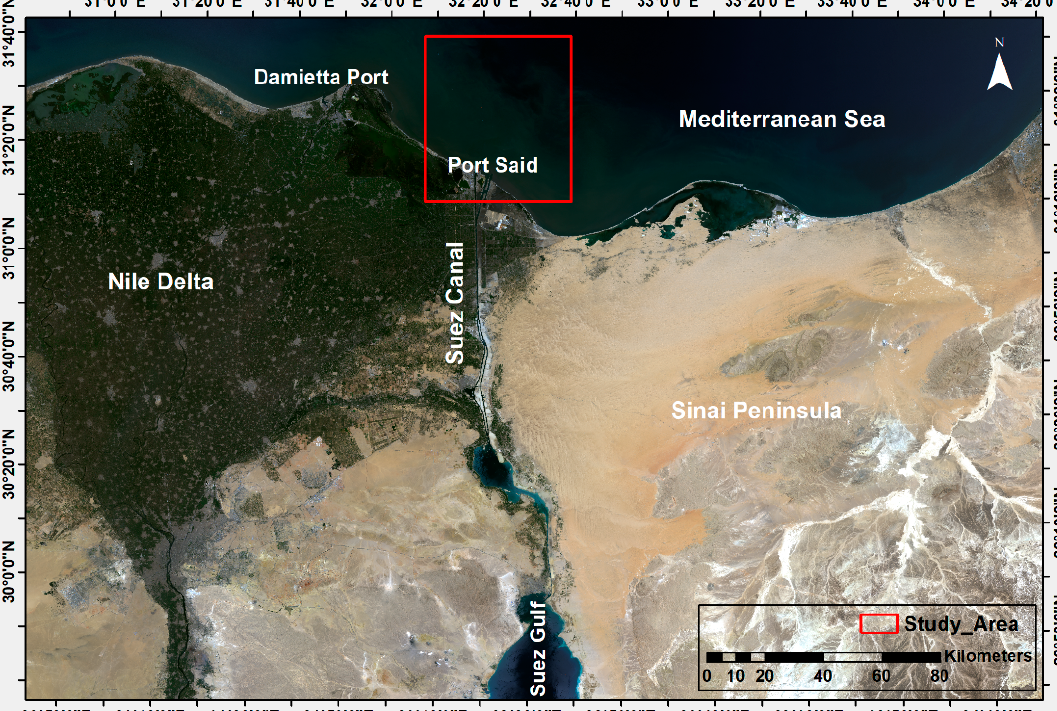
Figure 1. Due to the heavy load of shipping movement, there is a high probability of oil slicks. The study area covers nearly 50 km wide and 56 km long of seawater.